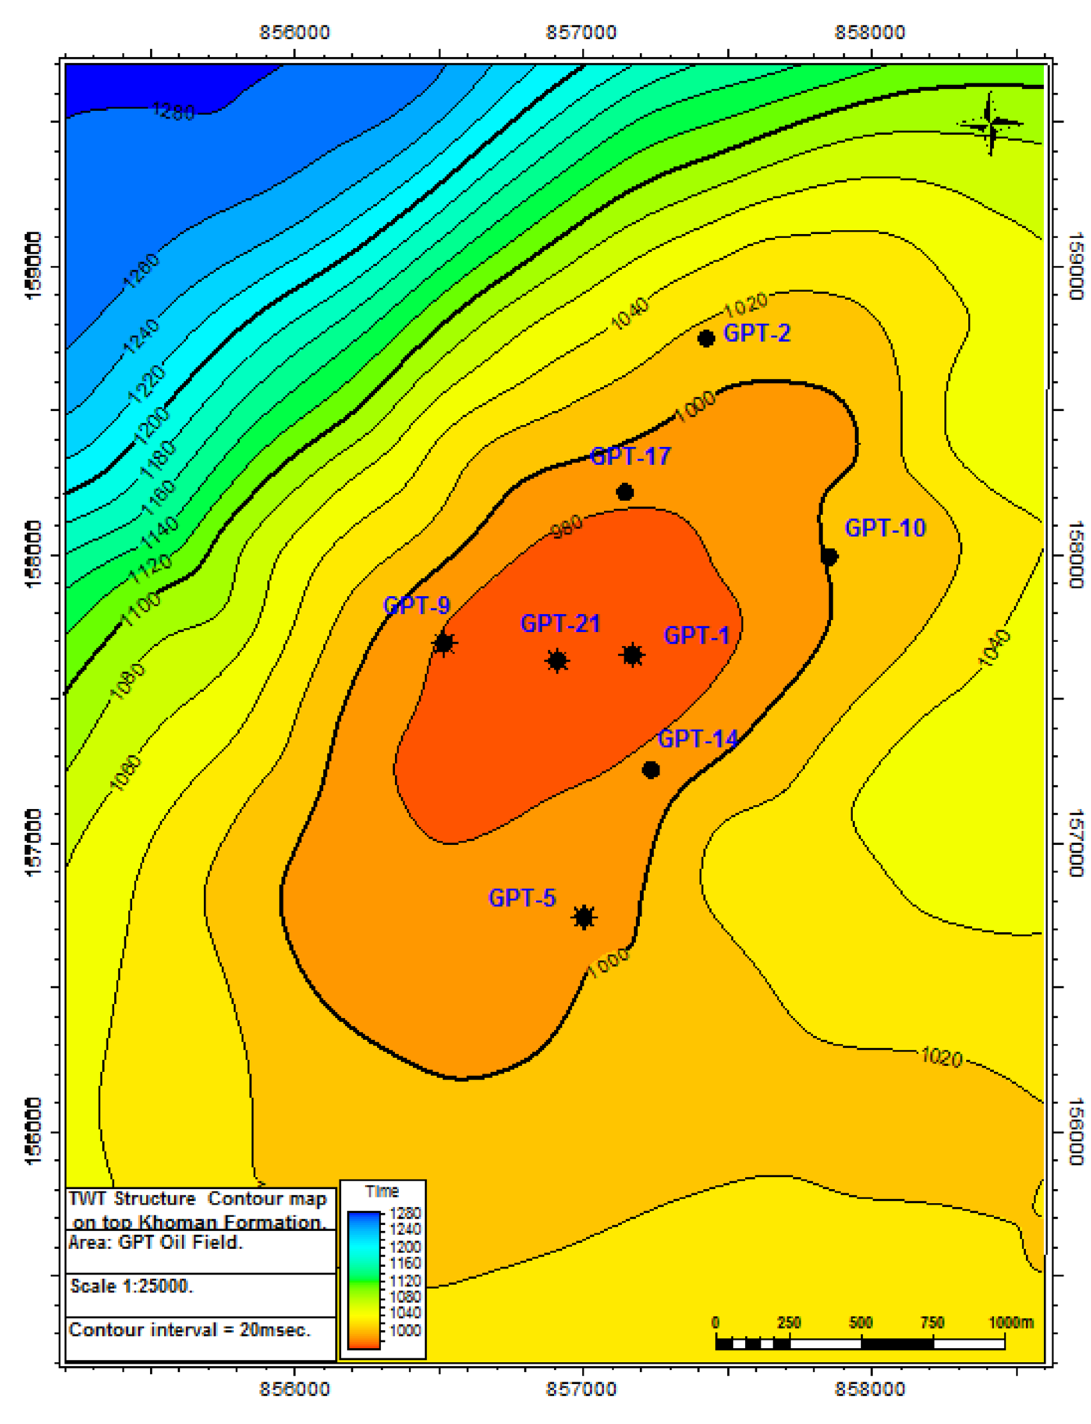
Fig. 8 TWT structure contour map of top Khoman